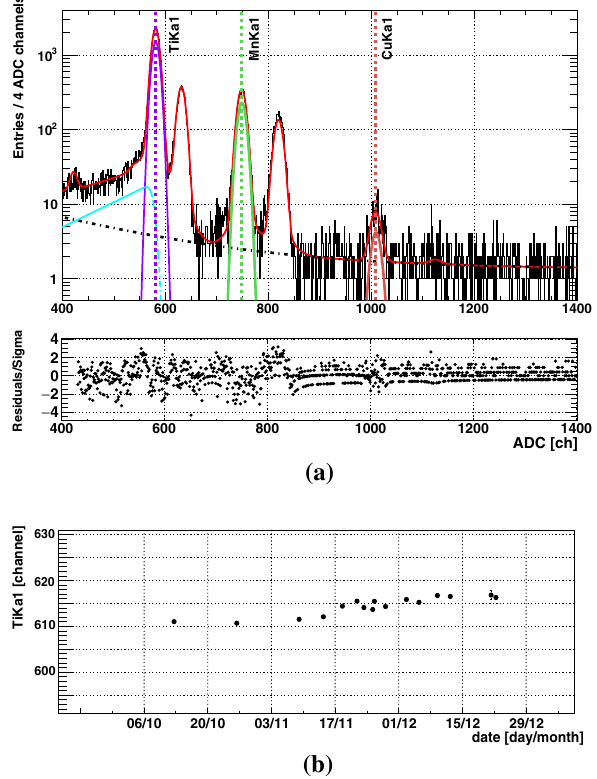
Fig. 6 a A typical fit to the PADC data from one SDD for 1 week; b the peak position of the titanium K α 1 from calibration fit to each data subset over the full data taking period, note that most of the statistical errors are smaller than the radius of the plot